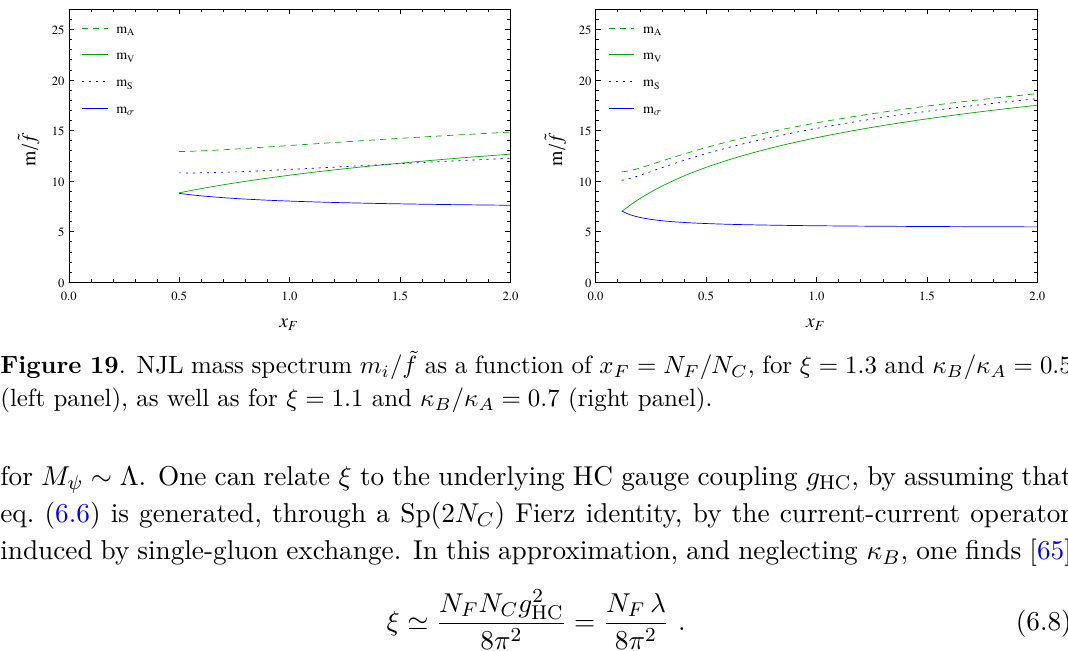
Figure 19 . NJL mass spectrum m i / (left panel), as well as for ξ = 1 . 1 and κ